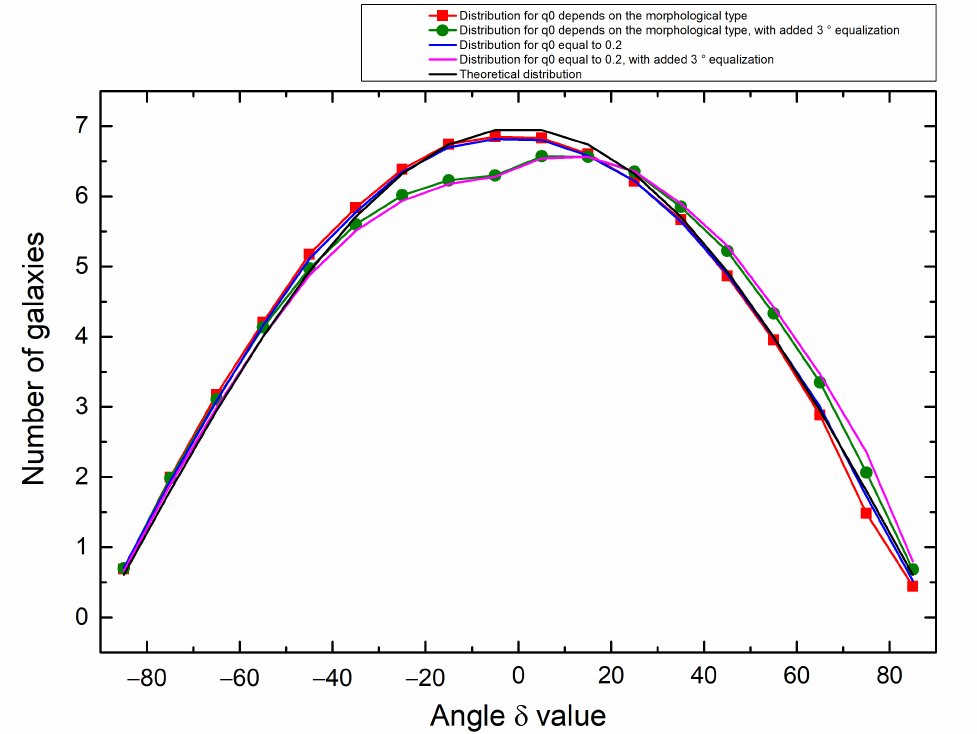
Figure 5. Simulated distributions of the angle δ D for group 17.